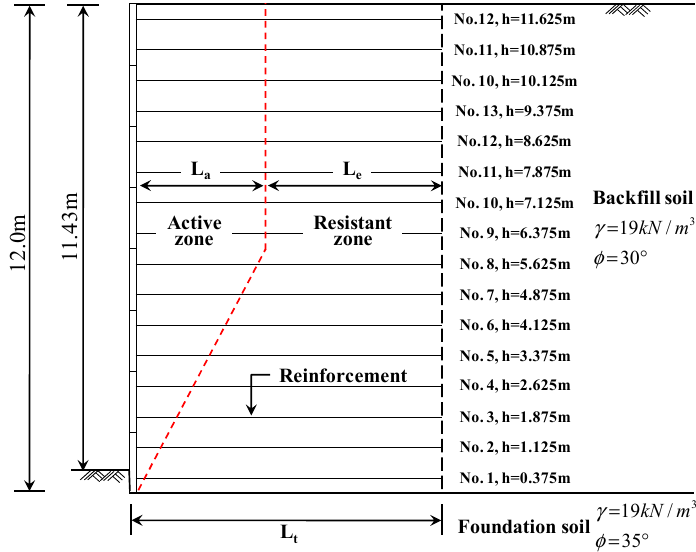
Figure 11. Cross-sectional view of design case.